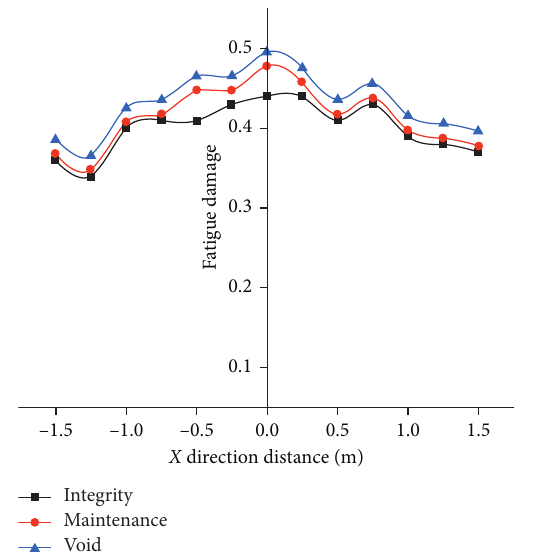
Figure 17: Fatigue damage distribution in X direction at bottom of base under three conditions.